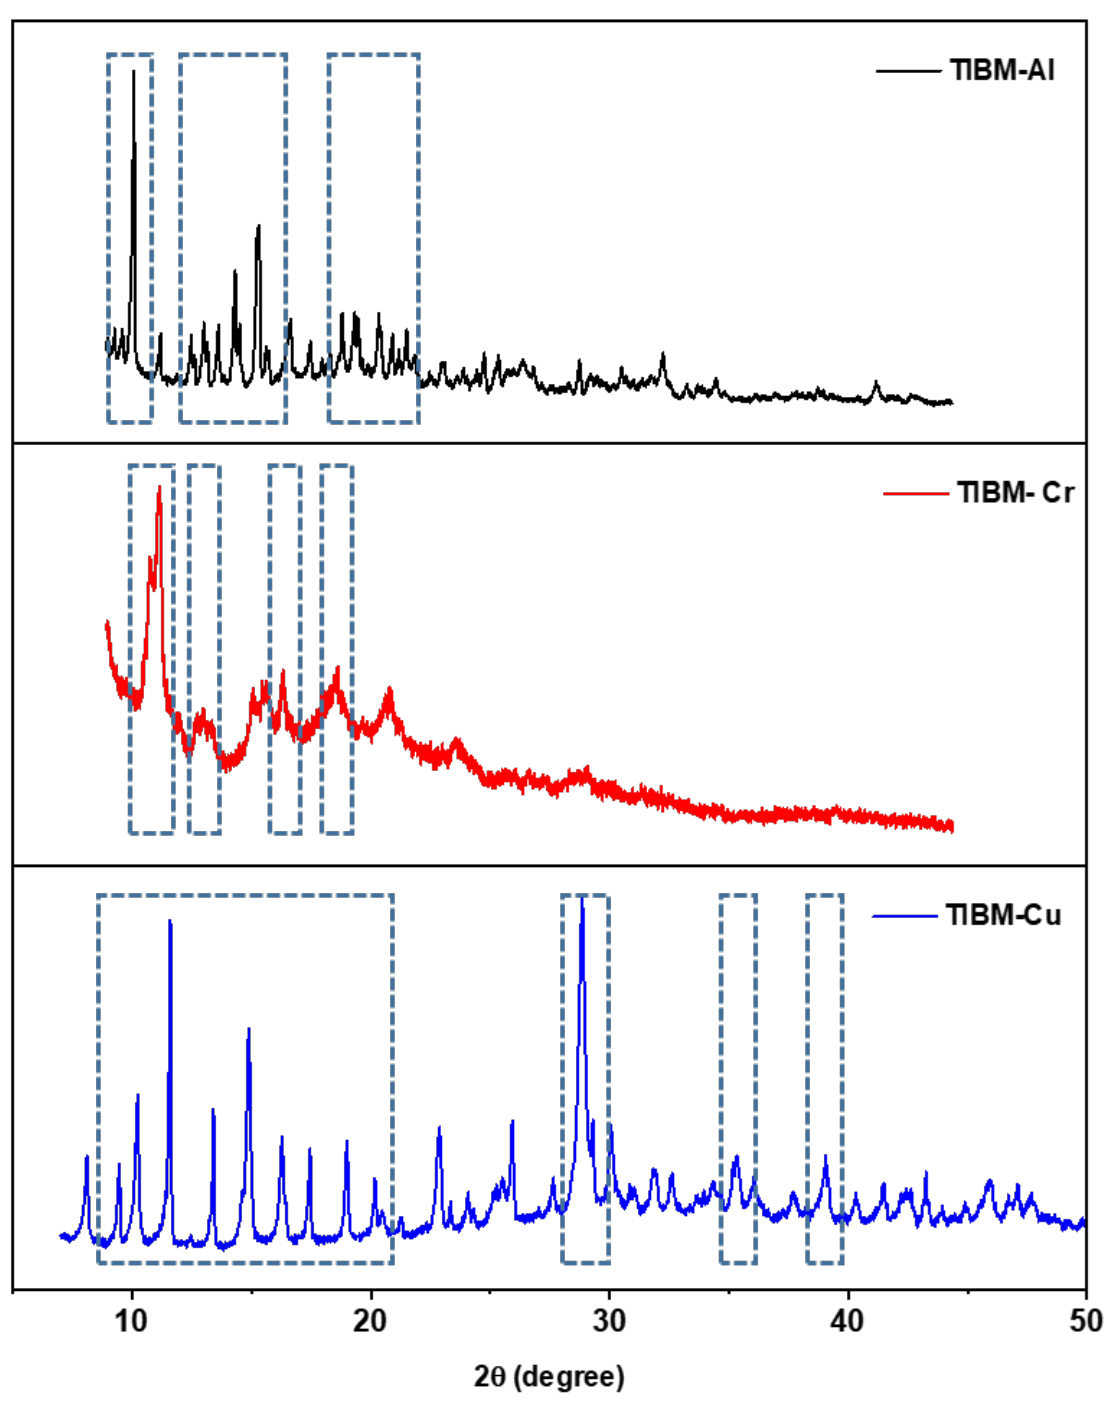
Figure 3. XRD patterns of MOF-Al, MOF-Cr, and MOF-Cu. (The dashed boxes represent the characteristic peaks that are matched with those of the reported MOFs) .